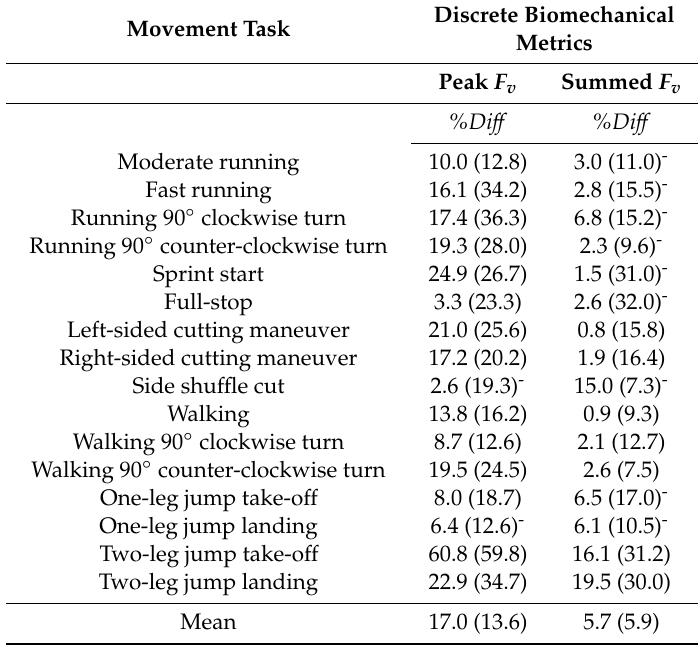
Table2. Absolutepercentdi ff erences( %Di ff )betweenANN-predictedpeak, inversedynamic-calculated peak, and summed vertical knee joint force ( Fv ). The superscript minus indicates an underestimation of the